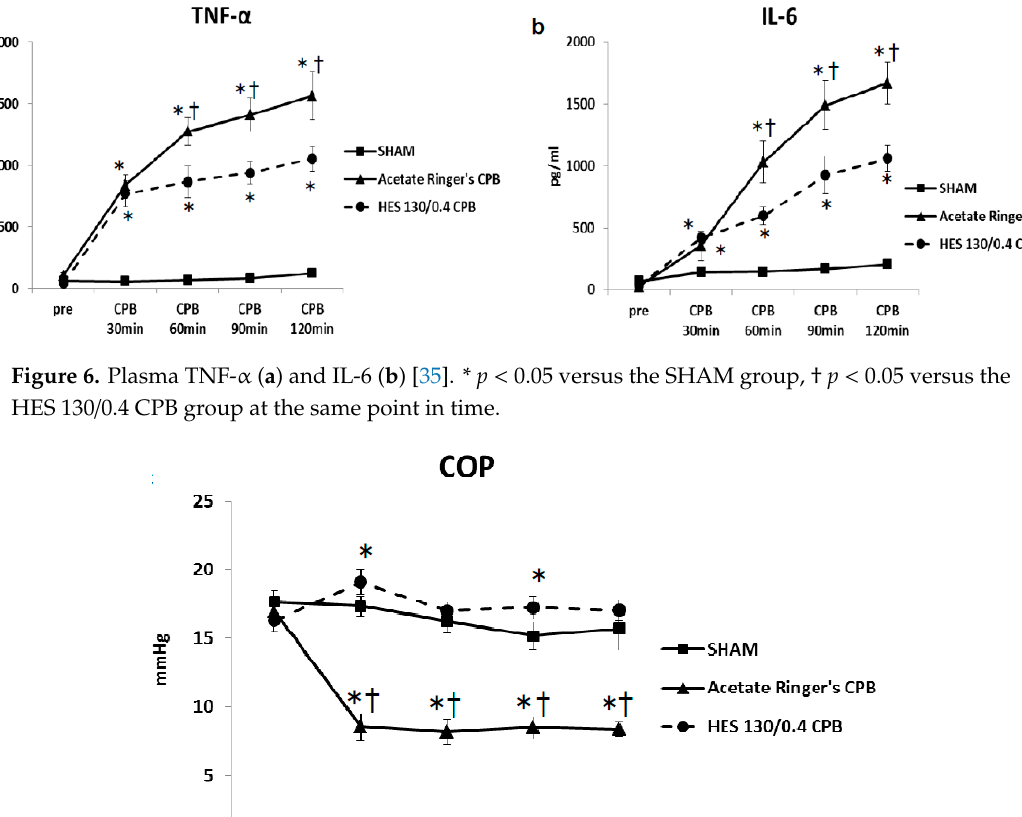
Figure 8. The wet-to-dry ratio of the lung at the end of experiment [35]. * p < 0.05 versus the SHAM group, † p < 0.05 versus the HES 130/0.4 CPB group. 2.4. Method of Suppressing the Inflammatory Response during Extracorporeal Circulation